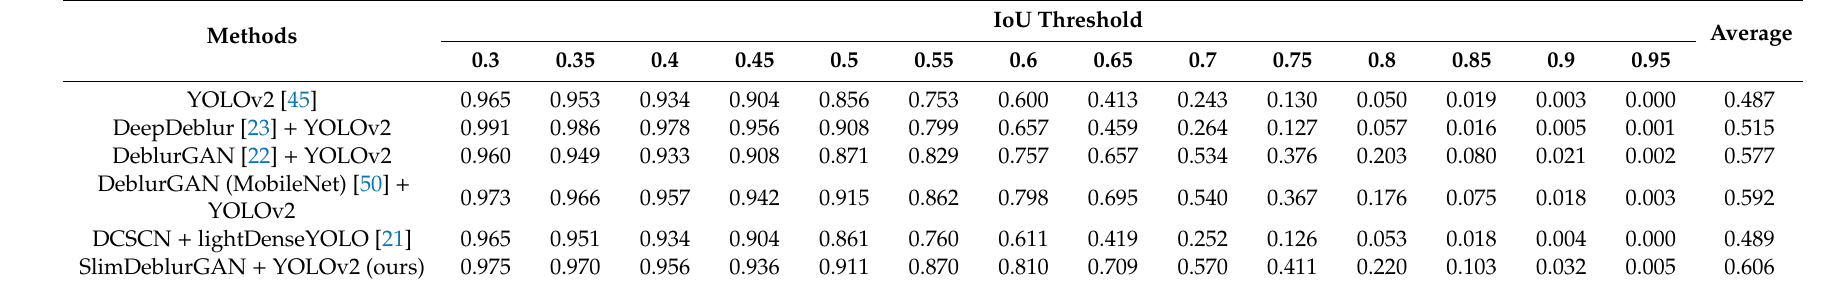
Table 14. Comparisons of F1 Score on